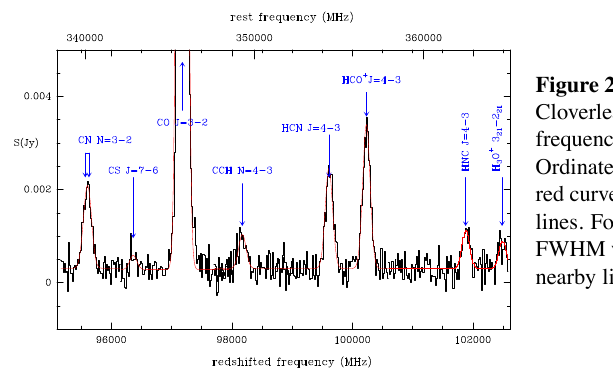
Figure 4. Line profiles of the strongest lines detected in the Cloverleaf Quasar. Red curves show the fits by a Gaussian whose FWHM is marked in blue. The upper 6 profiles are extracted from the spectra of Figs. 2 and 3, and the CO(1-0) line profile from GBT observations